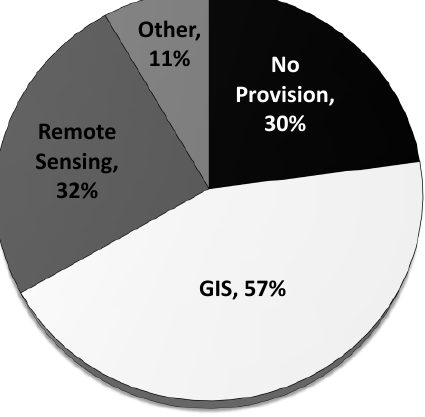
Figure 2 Percentage of UK BSc Environmental Science(s) degrees with dedicated GIS&T modules.